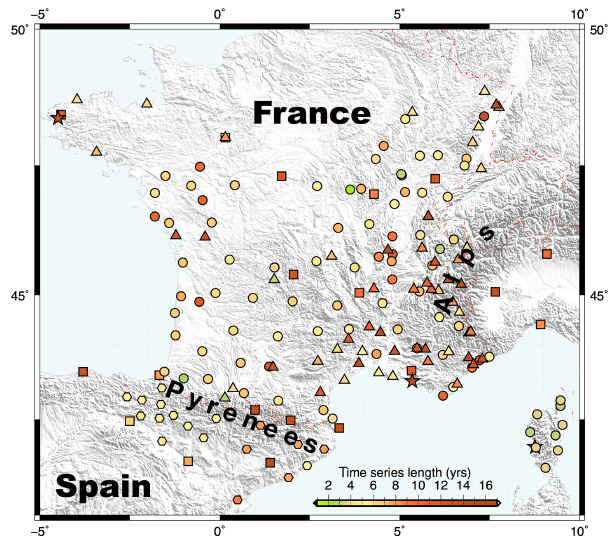
Figure 1. Distribution of the permanent stations used in this study. Symbols denote network (cf. text): stars – IGS; squares – EUREF- EPN; triangles: RENAG; circles – RGP; hexagons: Spanish net- works (Topo-Iberia, RGAN, CATNET, EPSH). Symbols are color- coded according to time-series